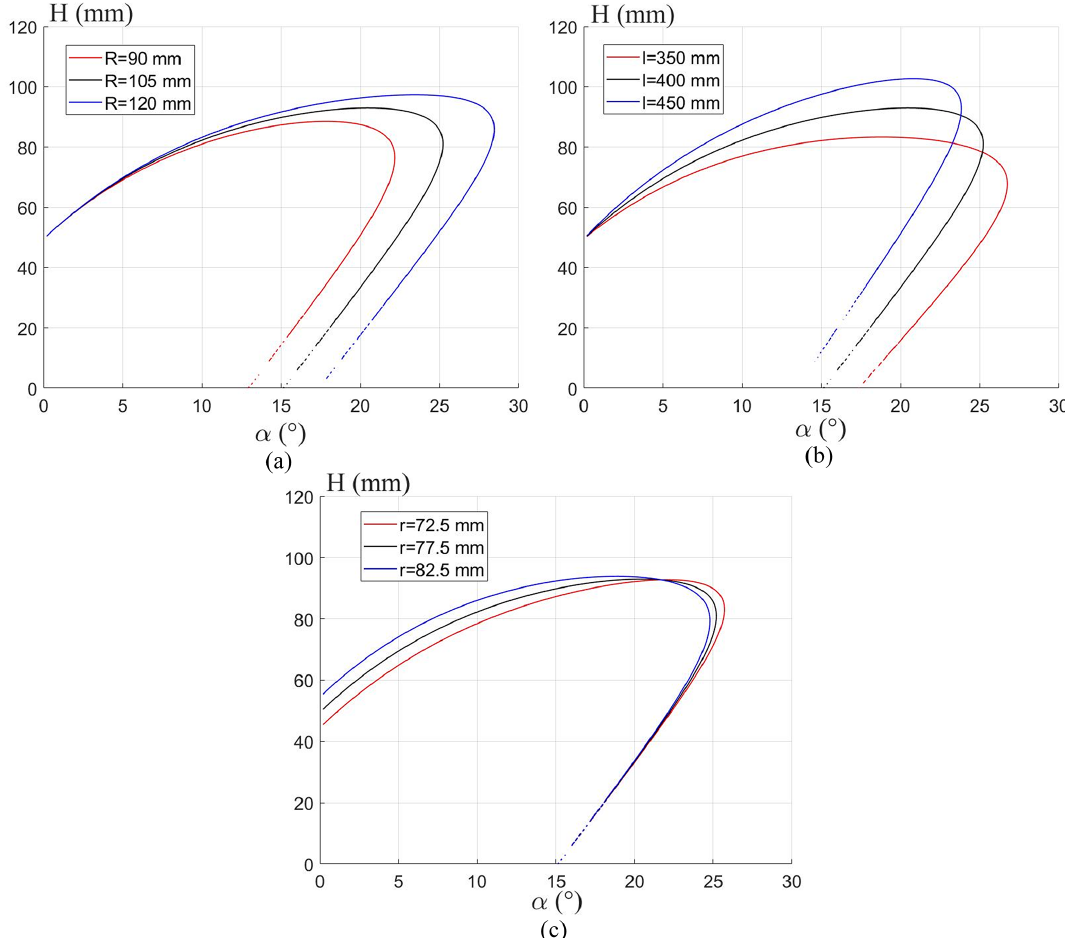
Figure 18. The influence of other geometric parameters on the maximum obstacle-crossing height of the robot.